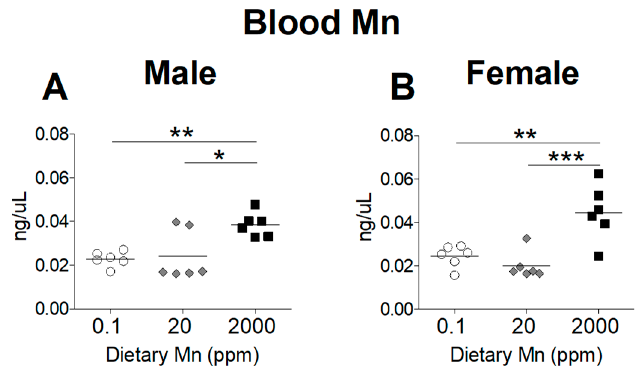
Figure 2. Whole blood Mn levels in mice on 0.1, 20, and 2000 ppm Mn diets . Mn content measured by inductively coupled plasma mass spectrometry (ICP-MS) in (A) male and (B) female mice at 12 weeks of age ( n = 6/sex). Data expressed as mean ± SEM. * p < 0.05, ** p < 0.01, *** p < 0.001.